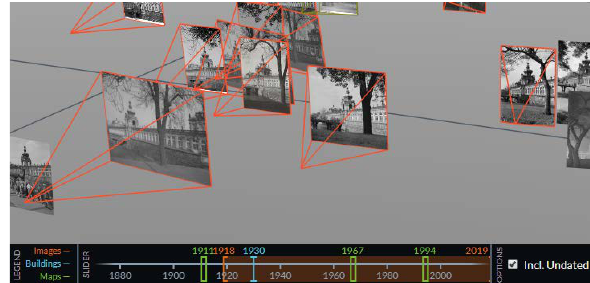
Figure 2. Timeline and photographs with pyramids indicating the direction of the camera